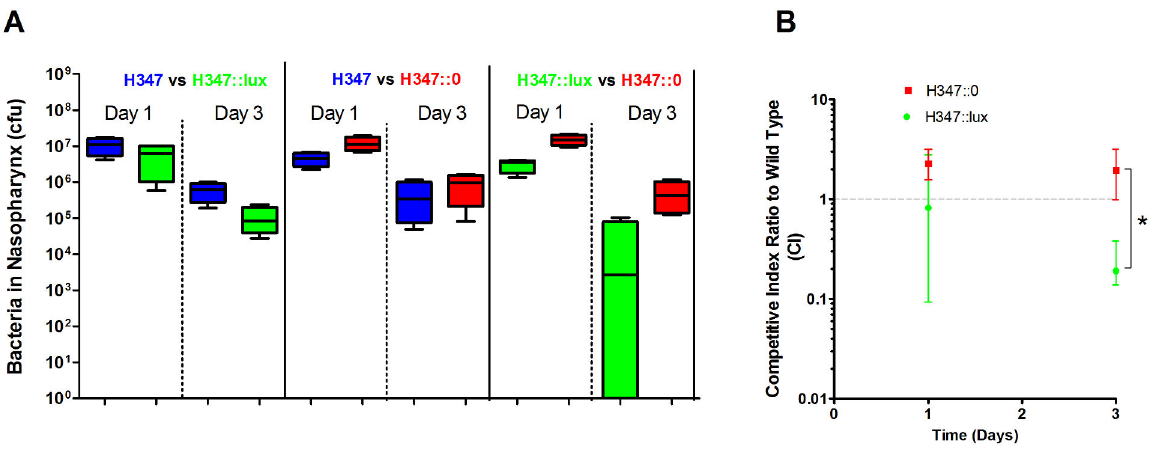
Figure 4. Bioluminescence confers in vivo competitive growth defects. Mice were infected intranasally using mixed inoculation paired combinations of H347::lux, H347, and H347::0 as shown. Mice were culled either at day 1 or day 3 post inoculation and the relative abundance of each strain was assessed through replica plating onto selective media (A, n=4 per group). These results were used to calculate competitive indices between each mutant strain and the isogenic parent strain H347 (B, Repeated measures Two way ANOVA with Bonferroni correction * p < 0.05). Error bars indicate median and interquartile range.